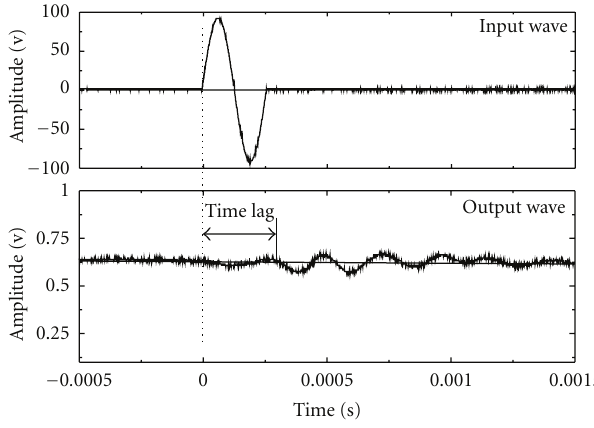
Figure 5: Typical waveform obtained from the test setup for a DAC specimen.